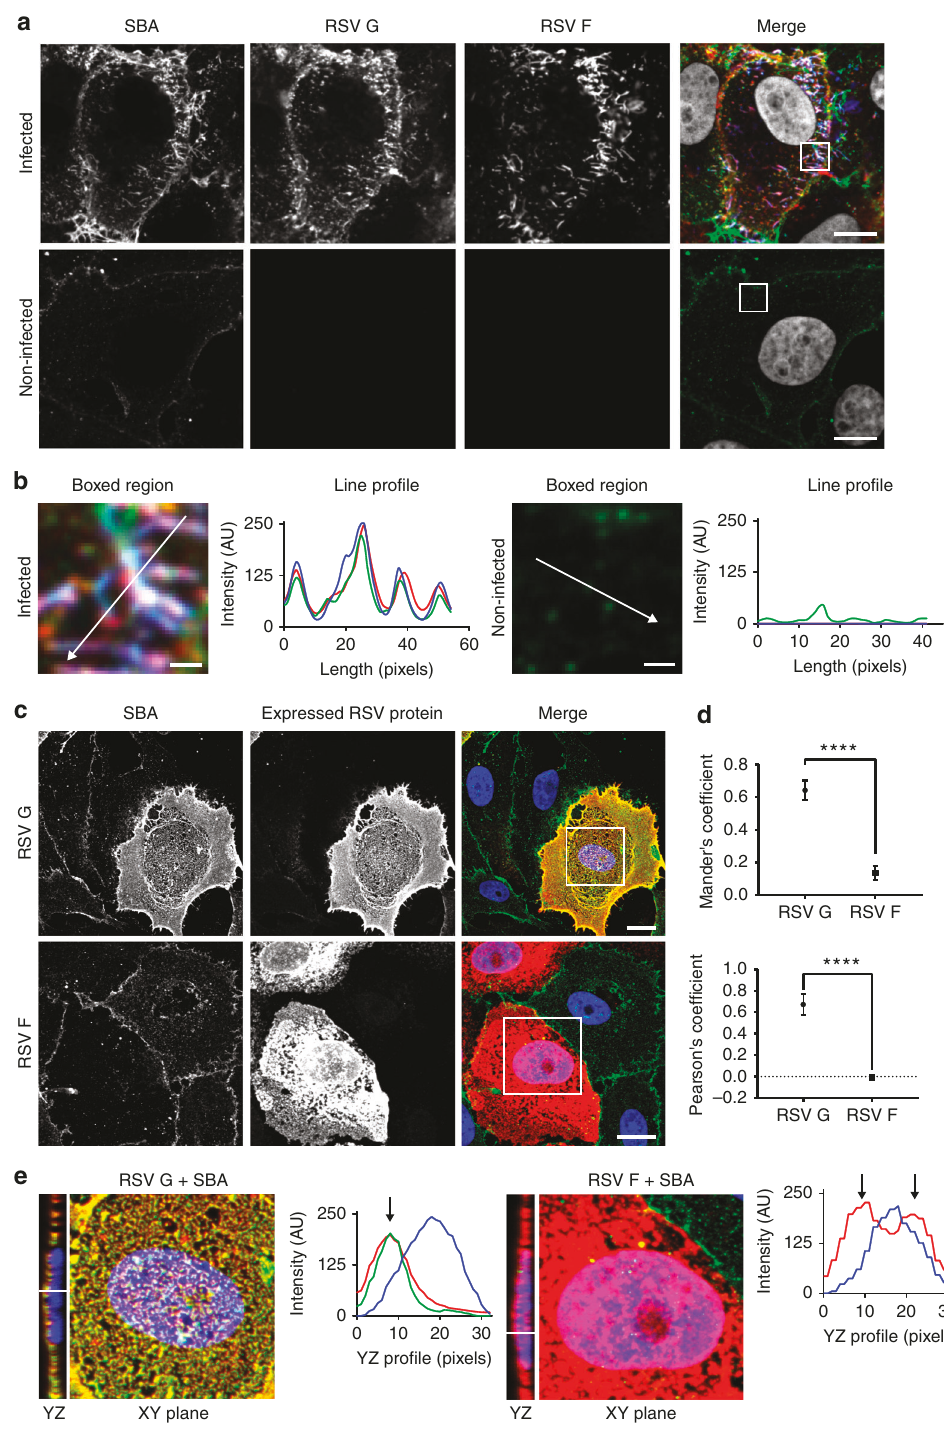
Fig. 1 SBA selectively binds RSV G. a Vero cells infected ( top ) or mock-infected ( bottom ) for 24 h with RSV A2 at an MOI of 1 were labeled with SBA-488 at 4 °C ( green ) before being fi xed and stained for RSV G ( red ), RSV F ( blue ), and nuclei ( gray ). Extended focus image is shown. Scale bar represents 10 µ m. b Enlarged cropped images from the white boxed regions from part a with intensity pro fi les showing colocalization along the direction of the white arrow . Scale bar represents 1 µ m. c Cells transfected for 24 h with RSV G ( top ) and RSV F ( bottom ) mRNA were labeled with SBA-488 at 4 °C ( green ) before being fi xed and stained without permeabilization for RSV G or RSV F ( red ) and nuclei ( gray ). Extended focus image is shown. Scale bar represents 15 µ m. d Mander ’ s colocalization coef fi cient and Pearson ’ s correlation between RSV G or RSV F and SBA. Dotted line indicates 0 correlation. n = 16 cells per group. Error bars represent 95% con fi dence interval. Asterisks indicates p < 0.0001 by Mann – Whitney U Test. e Enlarged cropped images from the white boxed regions from part c with YZ cross-sections ( left ). Intensity pro fi les, indicated by the white line on the YZ cross-section, show the expressed RSV protein on a higher plane than the nucleus as indicated by the arrow . Extended focus cropped images are